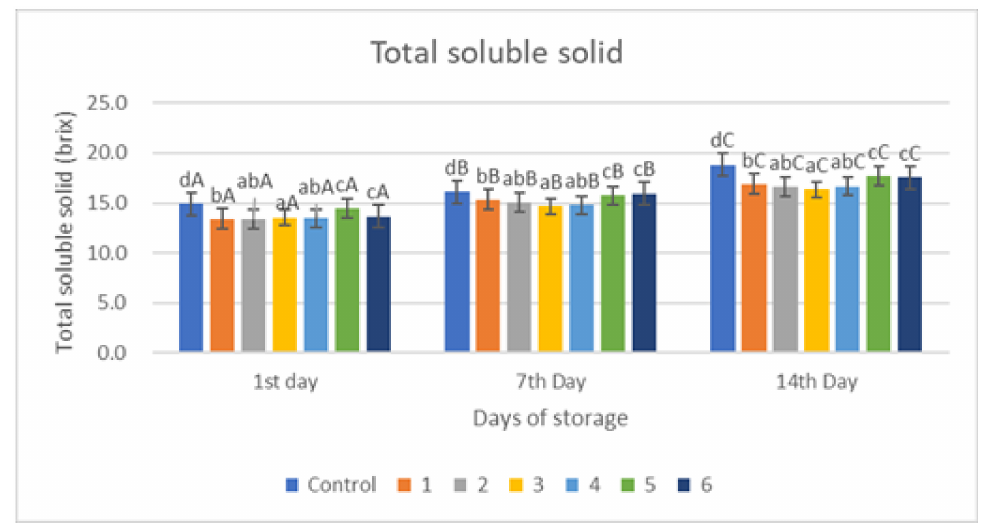
Figure 6. Total Soluble Solid of red chili during storage. a–d non-capital letters show the difference between the day of storage ( p < 0.05). A–C capital letters show the difference between the day of storage ( p < 0.05). Control: Uncoated Sample; 1: Gelatin75%-Pectin25%-Garlic Essential